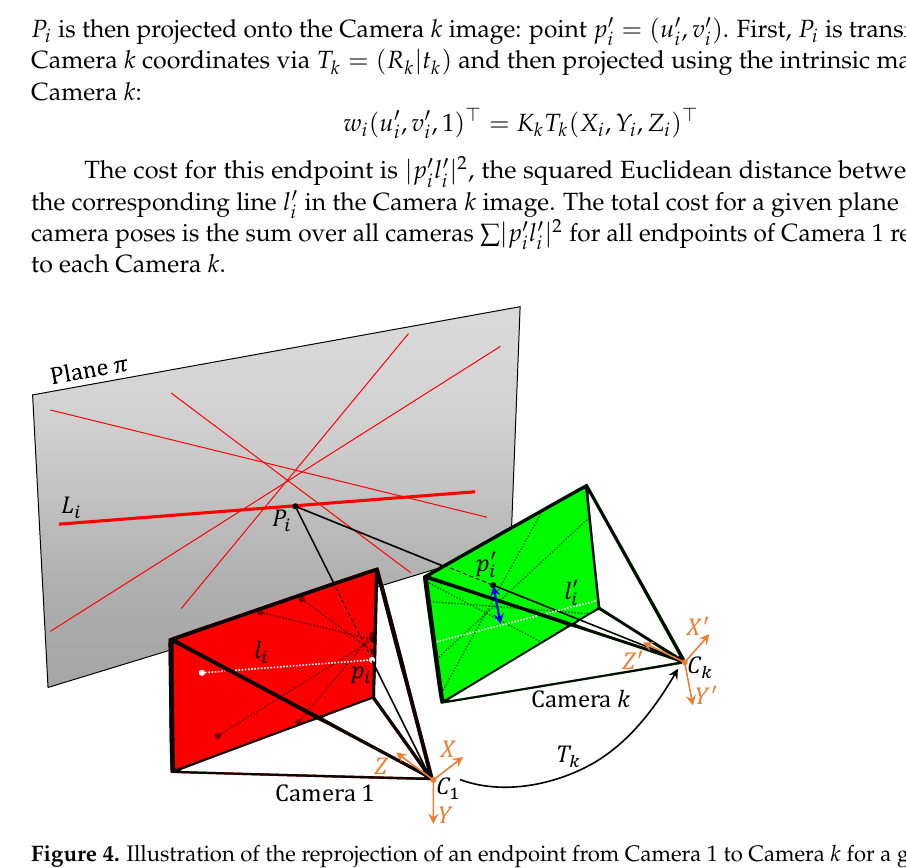
Figure 4. Illustration of the reprojection of an endpoint from Camera 1 to Camera k for a given plane and relative pose T k